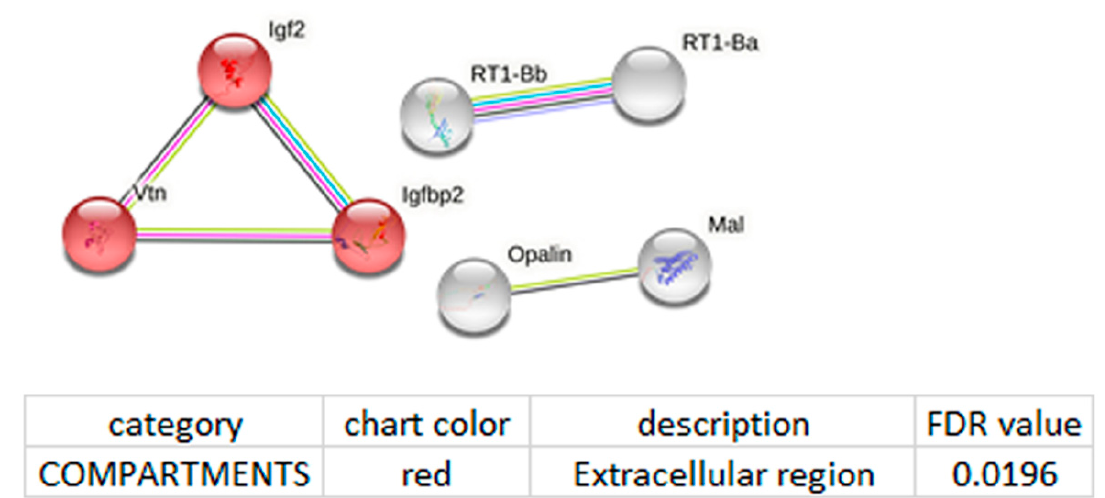
Figure 4. Functional enrichment analysis of the lncRNA Snhg4 network. Functional enrichment network was constructed by means of the STRING database [22] using the DEGs whose expression correlated with the expression of lncRNA Snhg4. Each node represents all the proteins produced by a single protein-coding gene. The key nodes are insulin-like growth factor 2 (Igf2); insulin-like growth factor binding protein 2 (Igfbp2); vitronectin (Vtn); RT1 class II, locus Ba (RT1-Ba) and RT1 class II, locus Bb (RT1-Bb). Edges represent protein–protein associations. Purple lines indicate experimentally determined interactions; blue lines denote known interactions from curated databases; black lines indicate coexpression; green lines mean results of text mining; and grey lines indicate protein homology. The protein–protein interaction (PPI) enrichment p -value is 0.0778; this means either that the current set of proteins is a random collection of proteins that are not very well connected or that these proteins have not been studied very much and their interactions might not yet be documented in STRING.